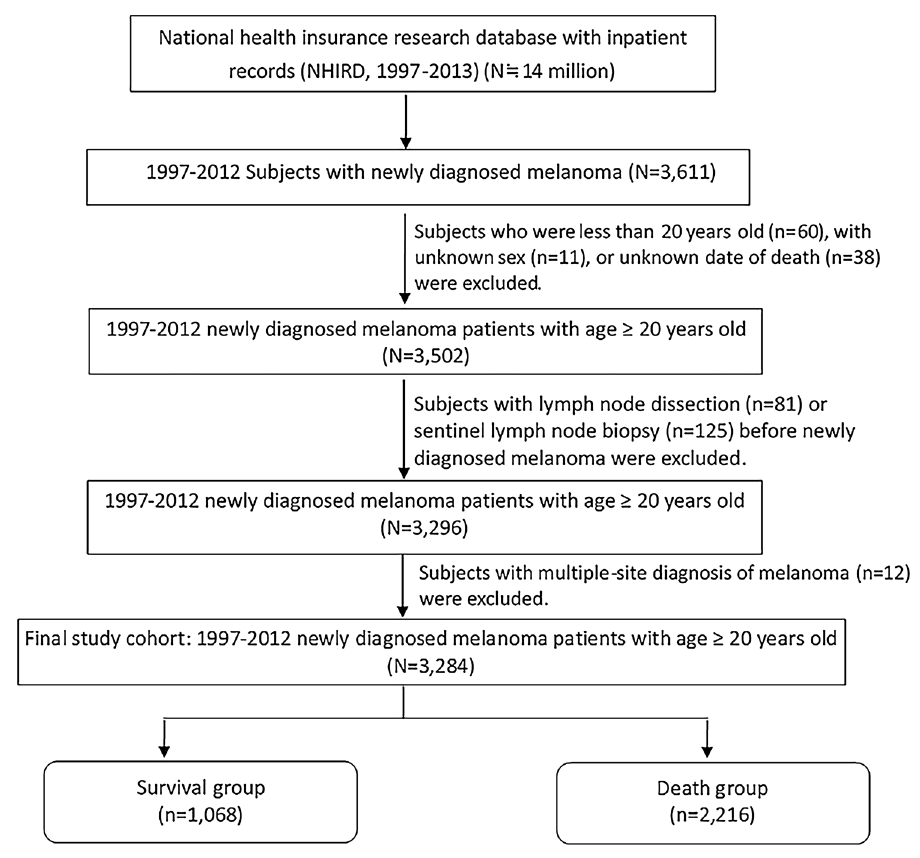
Figure 1. Design and flowchart of patient